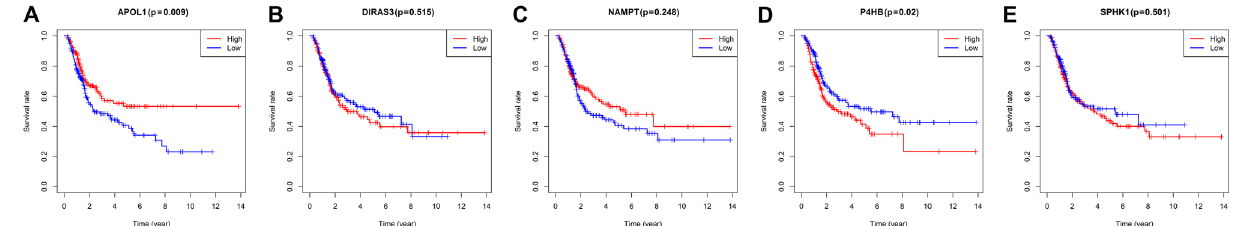
Figure 6. Survival analysis of prognostic model related genes. Kaplan–Meier curve of patients with different expression levels of APOL1 ( A ), DIRAS3 ( B ), NAMPT ( C ), P4HB ( D ), SPHK1 ( E ). The median expression level was used as the cut-off value. Red line and blue line represent high expression and low expression group, respectively.